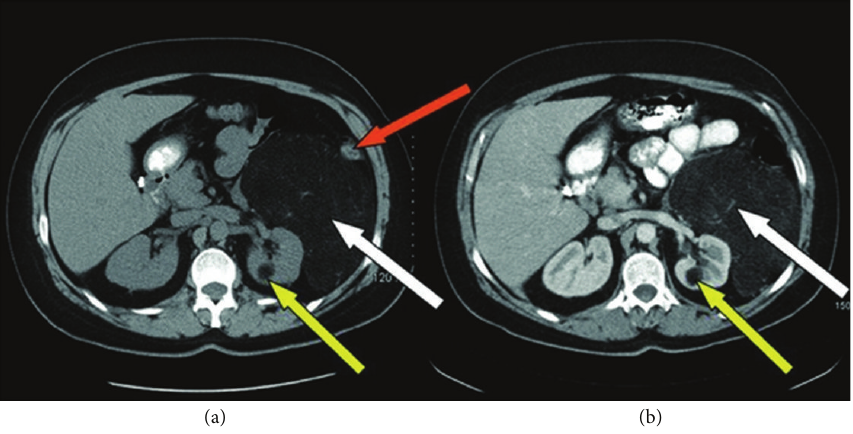
Figure 1: (a) Oral contrast and (b) IV and oral contrast: abdominal computerized tomography demonstrating an encapsulated fatty vascular mass (white arrows) lateral to the left kidney measuring 19.3cm × 13.5 cm × 10.7 cm with prominent vascular dependence on the left renal vein and artery as well as a 2 cm posterior midpole homogeneous fatty density (yellow arrow). Left colon is laterally displaced (orange arrow). Reproduced from [18].